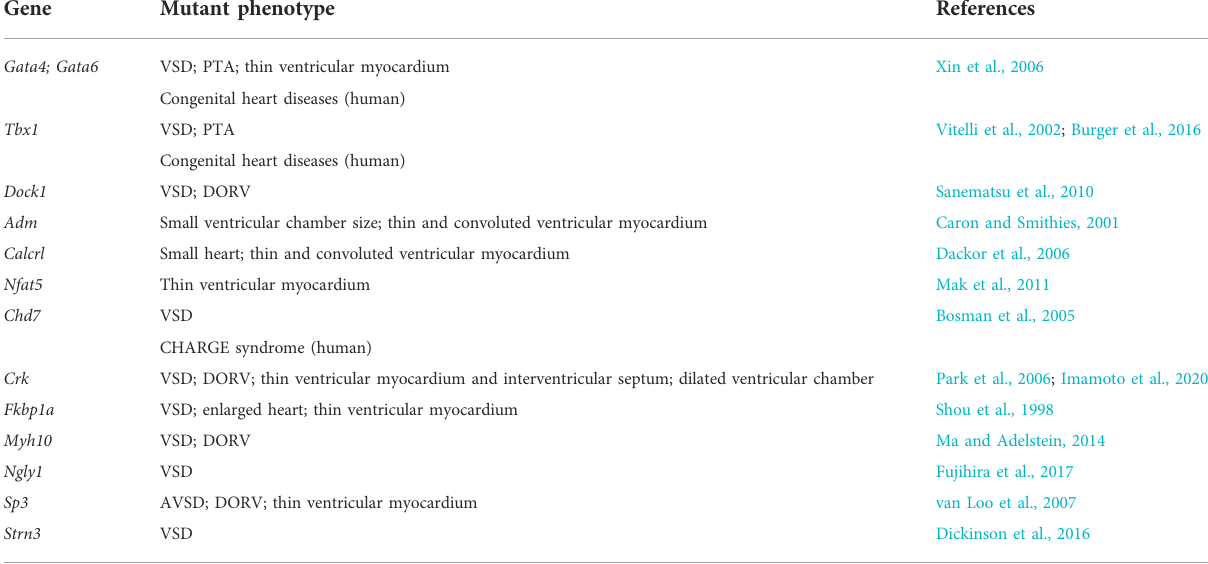
TABLE 2 List of genes and mutant phenotypes related to fetal nuchal edema with cardiac anomalies in mice (loss-of-function mutations). Gene Mutant